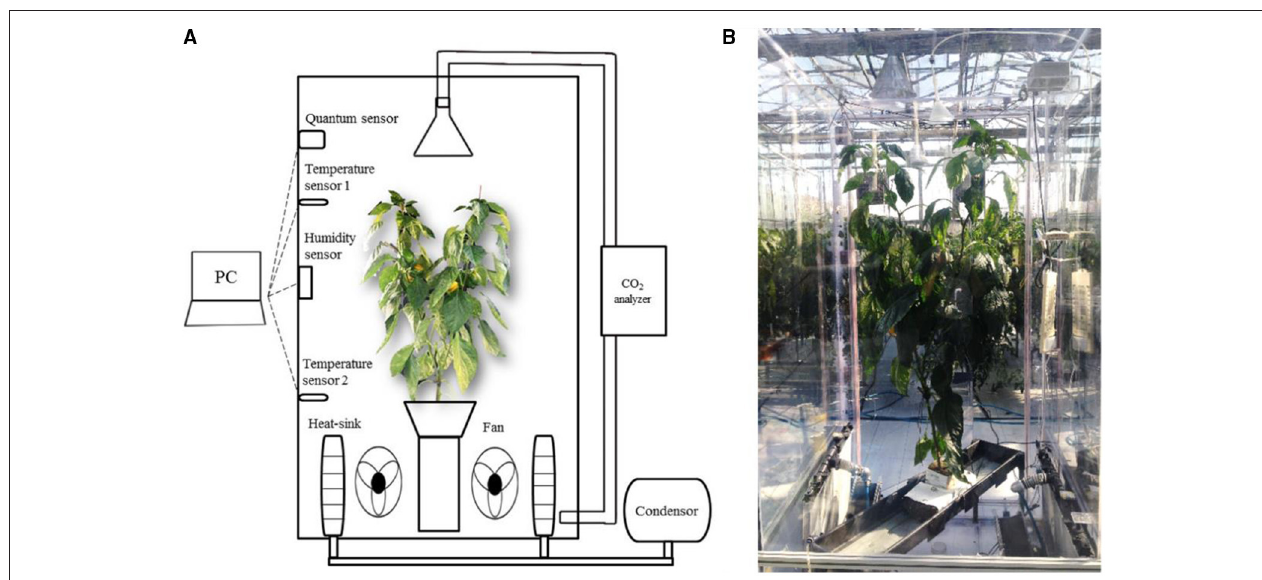
FIGURE 1 | A schematic diagram (A), and actual installation (B) of a closed growth chamber for measuring CO 2 consumption of paprika plant.